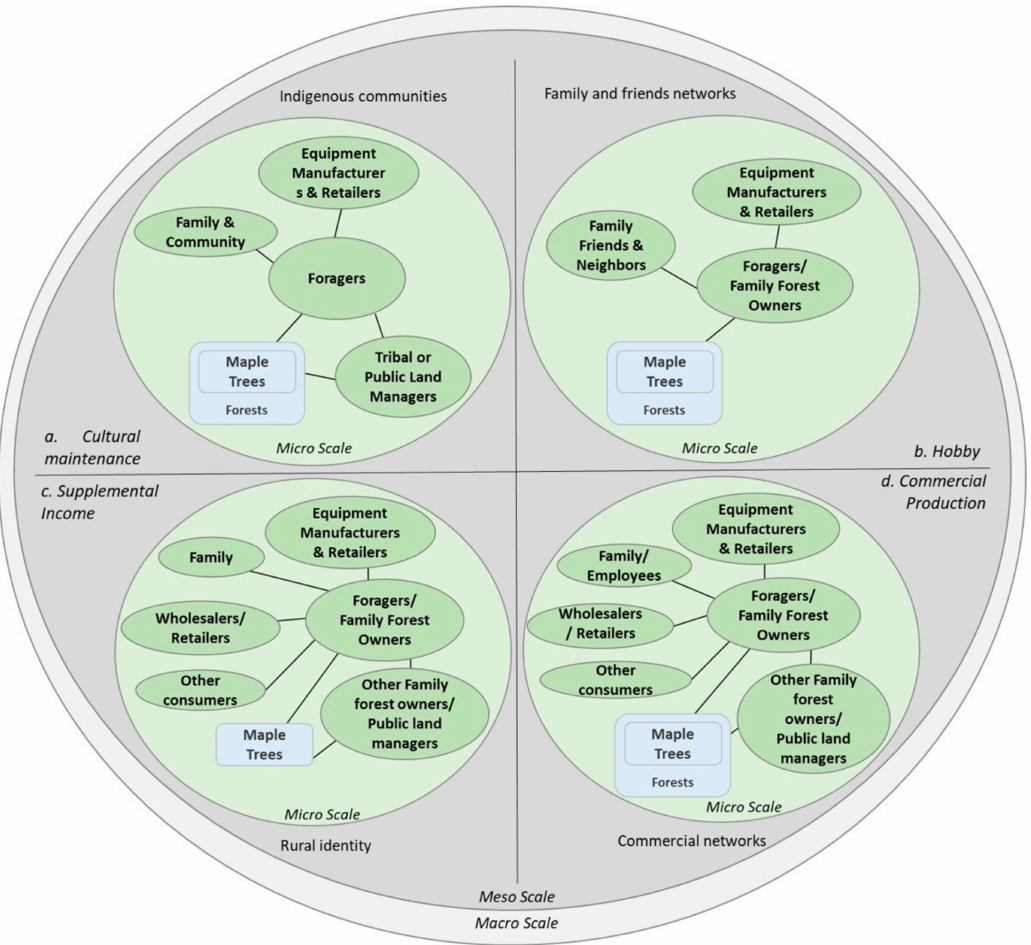
Figure 2. Maple syrup collection in four contexts: actor networks in sugaring as ( a ) cultural maintenance, ( b ) hobby, ( c ) supplemental income, and ( d ) commercial